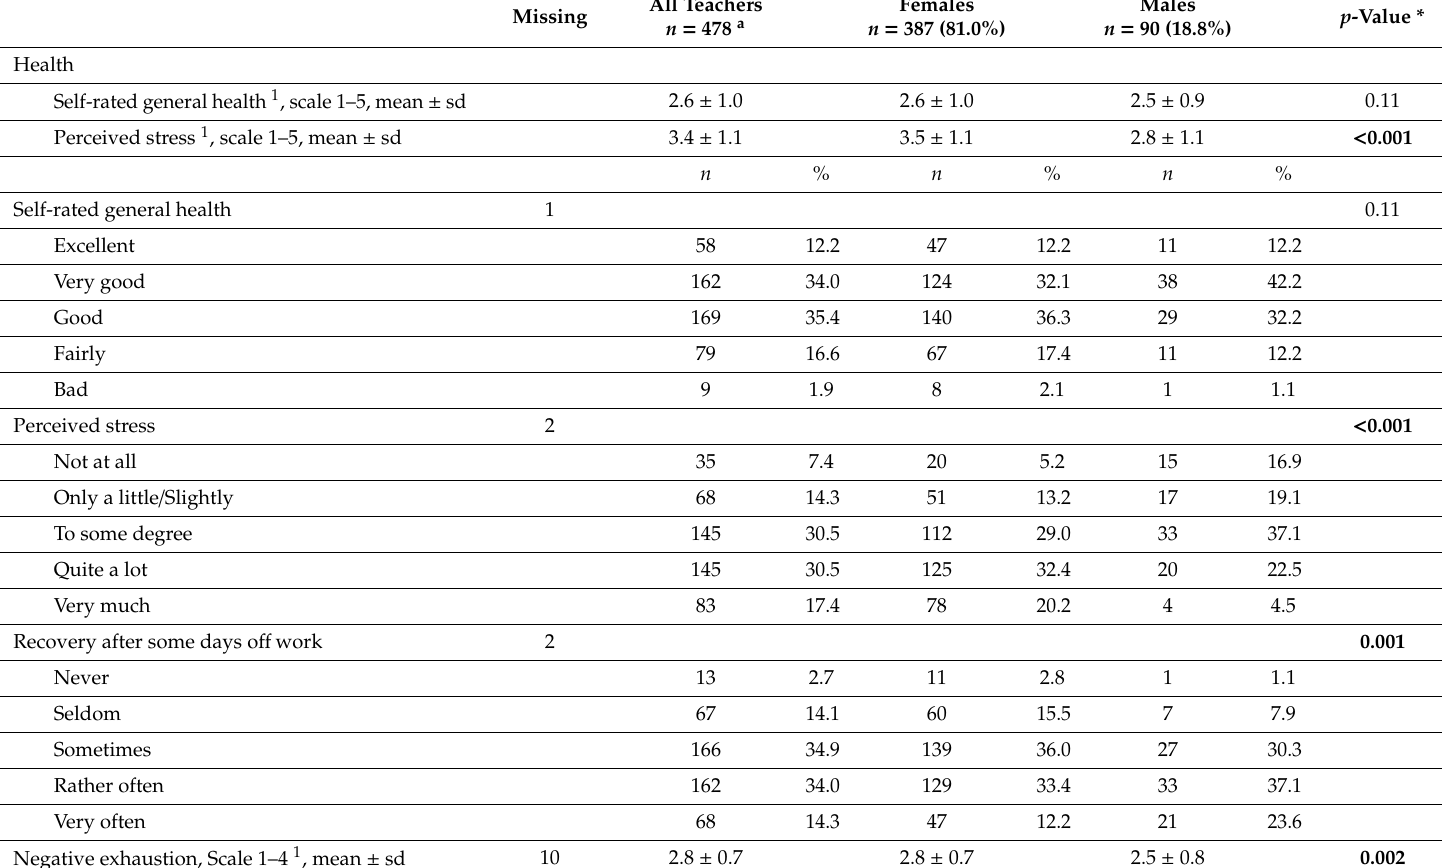
Table 2. Health among teachers at